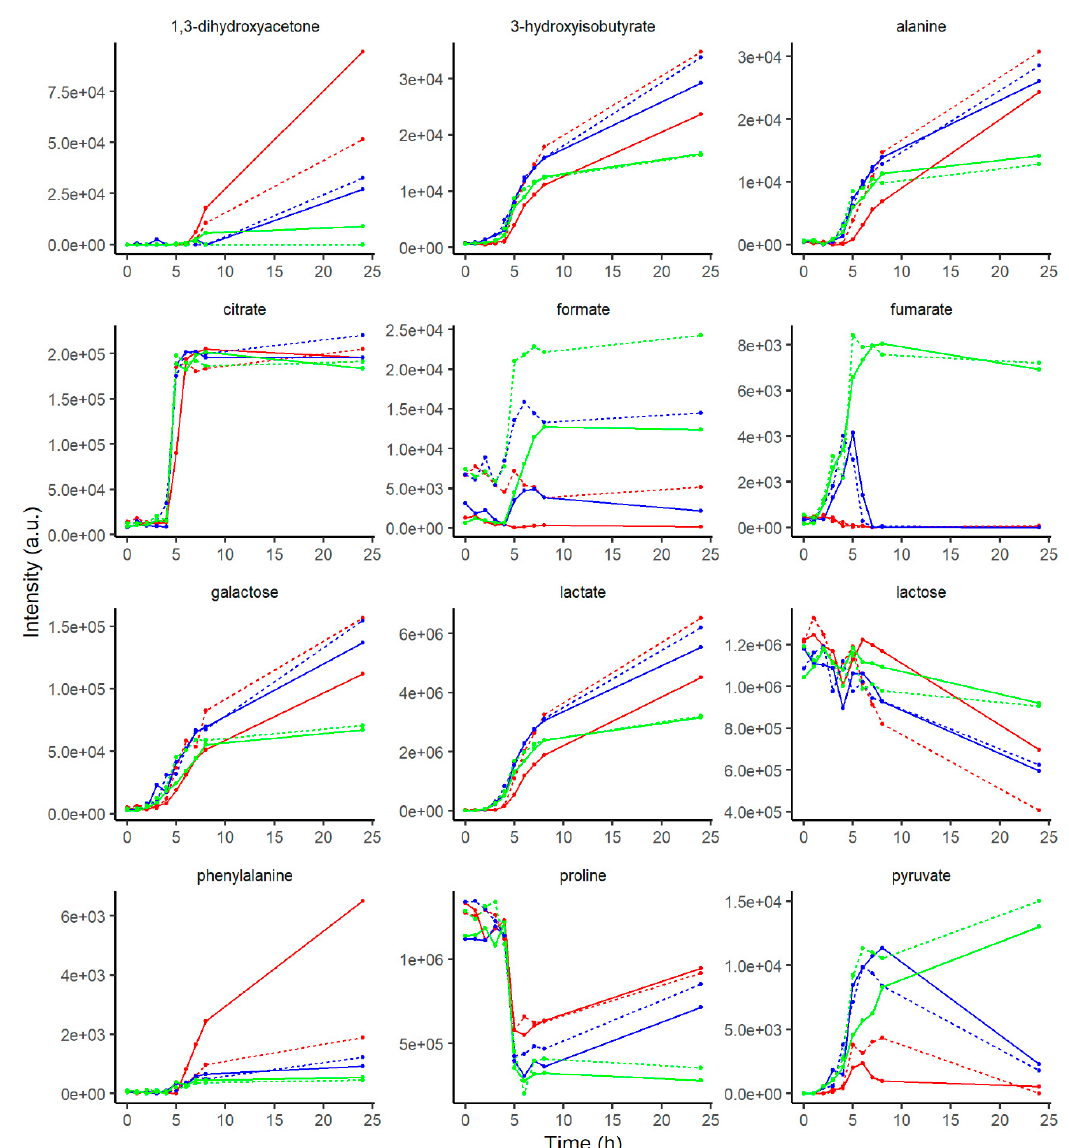
Figure 2. Metabolite development in yoghurt according to the applied experimental design. Points are an average of two replicate samples. Colors denote starter culture L. delbrueckii ssp. bulgaricus (red), S. thermophilus (green) and their combination (blue). The line type denotes milk heating temperature: 99 °C ( ___ ) and 105 °C (---).